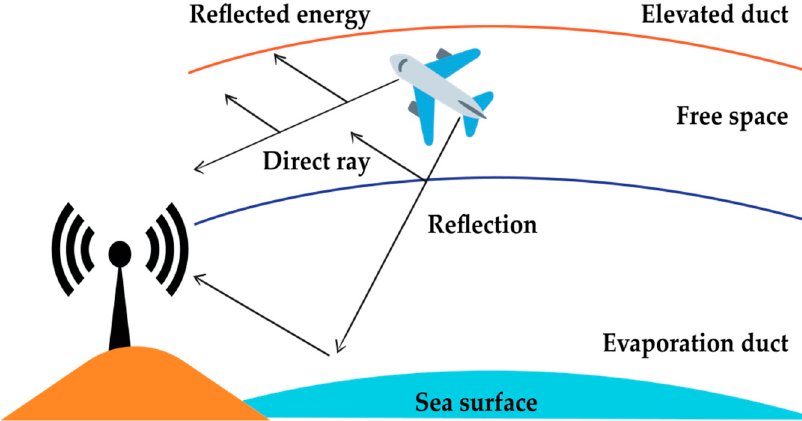
Figure 2. Radio wave propagation in air-to-ground communication for over-the-sea channels.